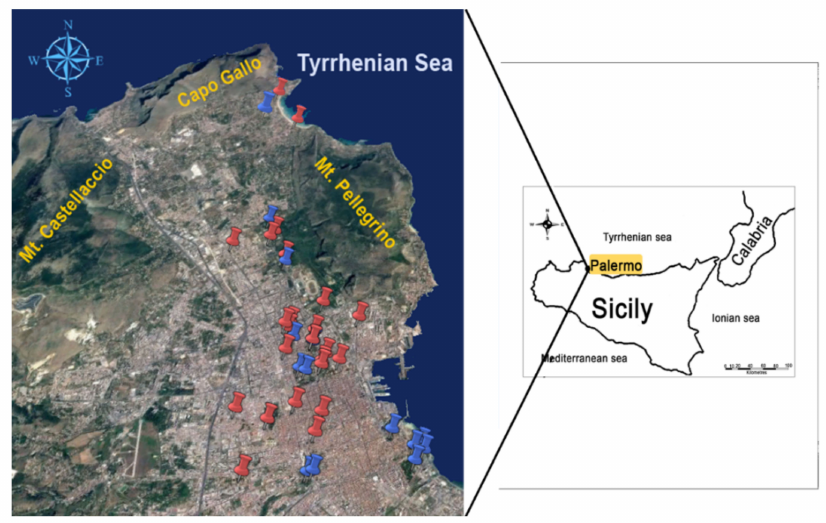
Figure 1. Study area in relation to sampling site location of Ficus macrophylla . Red indicates samples collected from the long main urban road; blue indicates samples collected from city